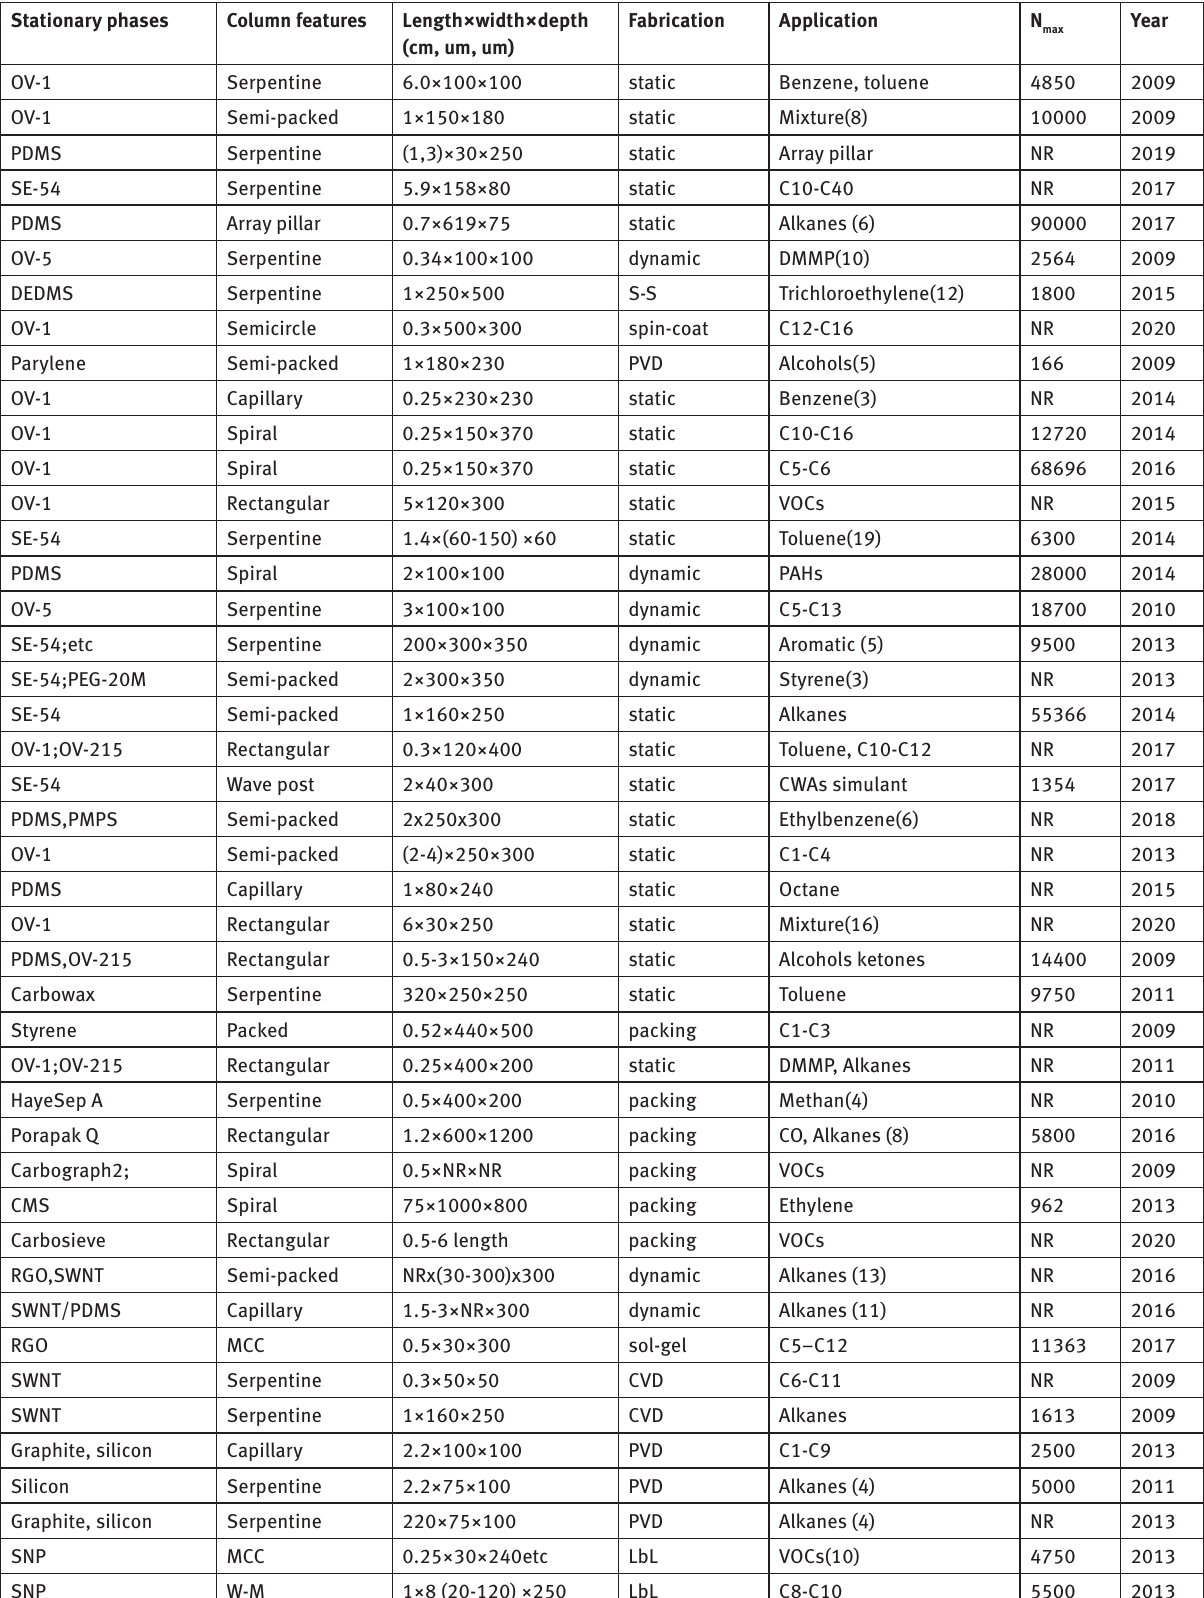
Table 1: Summary of MEMs column characteristics and stationary phases Stationary